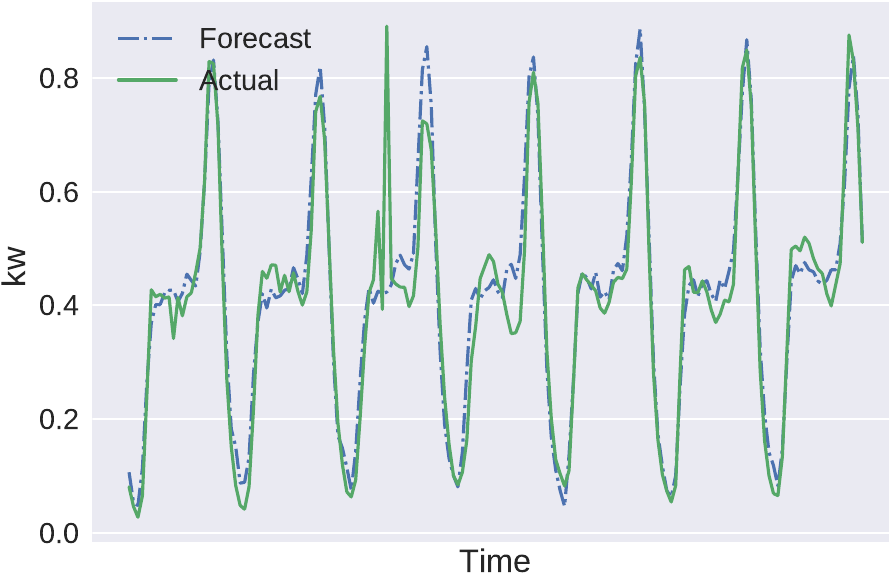
Figure 18. Forecast plot for 10% ≤ SMAPE < 20%.